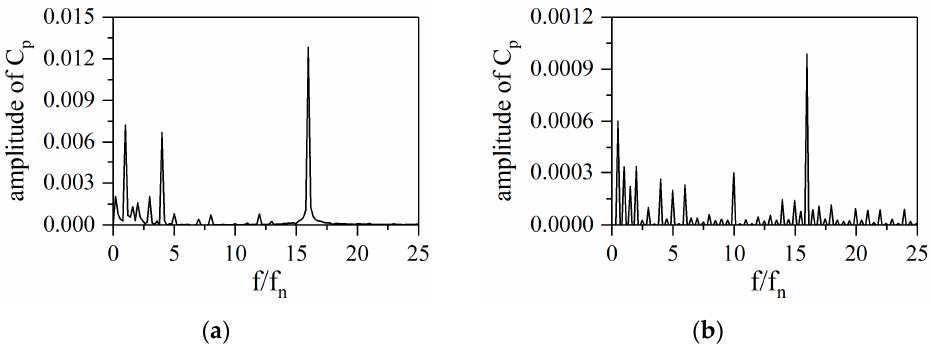
Figure 20. Frequency domain diagram of pressure coefficient at TP6. ( a ) P1; ( b ) P2.